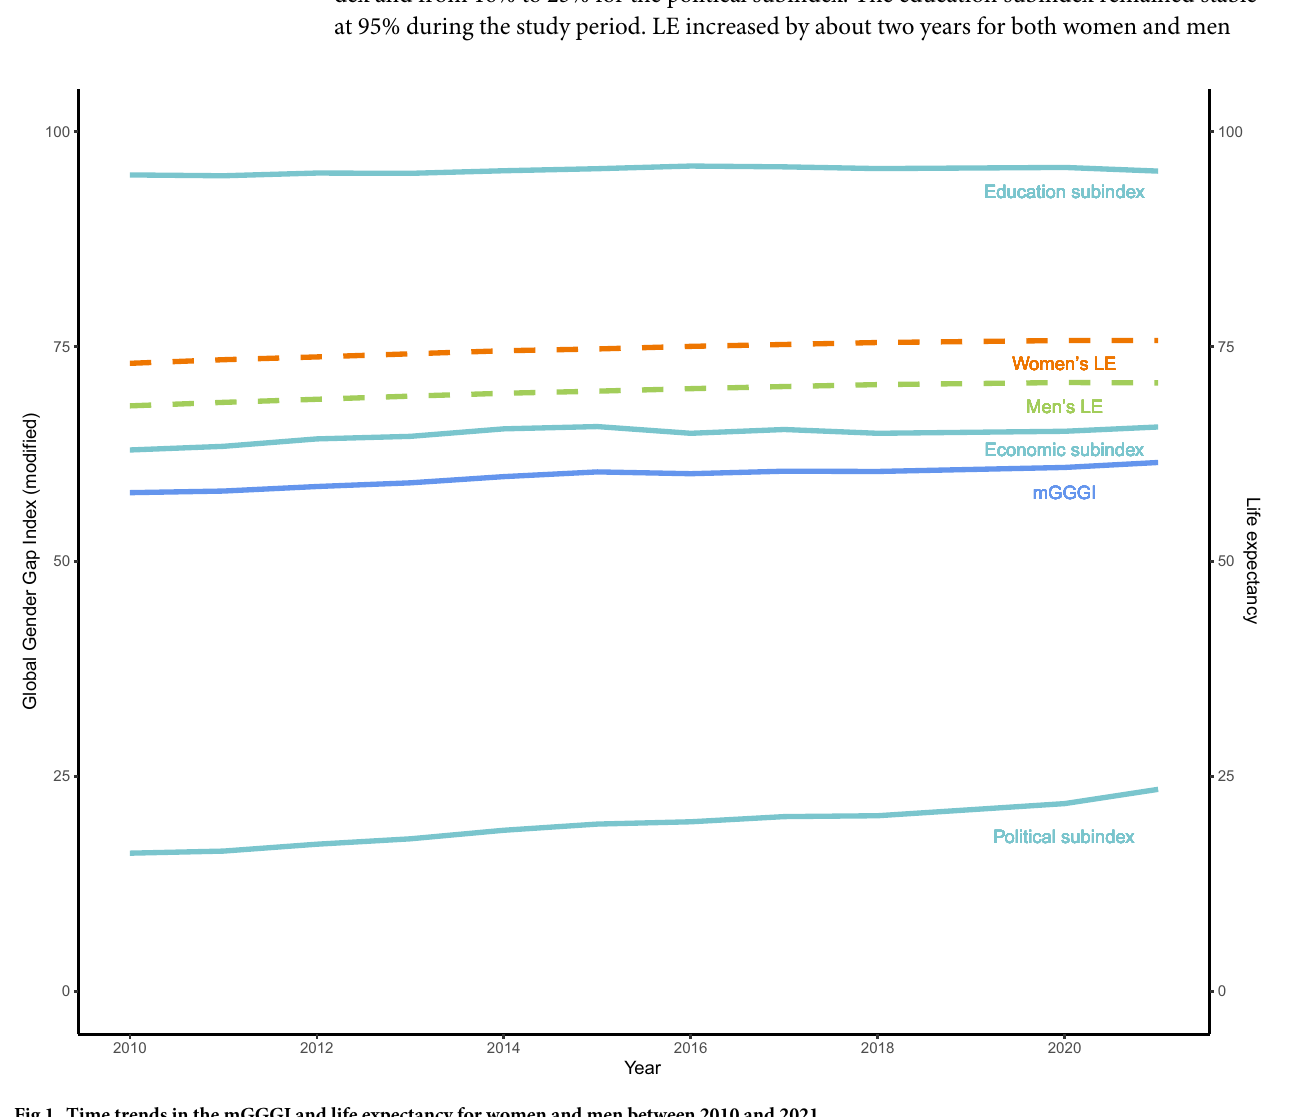
PLOS Global PublicHealth | https://doi.org/10.1371/journal.pgph.0001214 March 6,